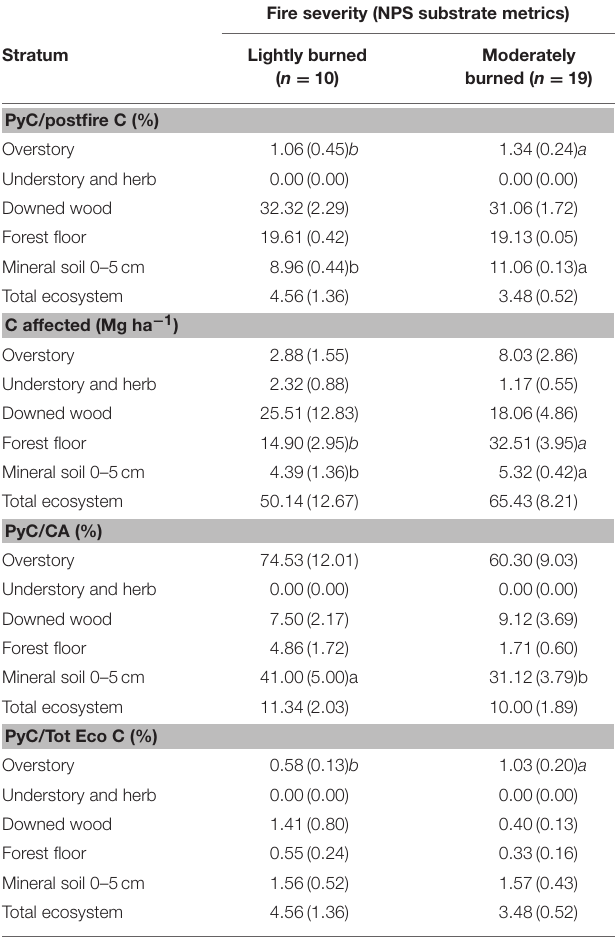
TABLE 5 | Post-fire PyC (estimated as PyC CTR via chemical oxidation) proportions of post-fire C, C affected, and post-fire total ecosystem C for plots measured before and after fire in mixed-conifer forest